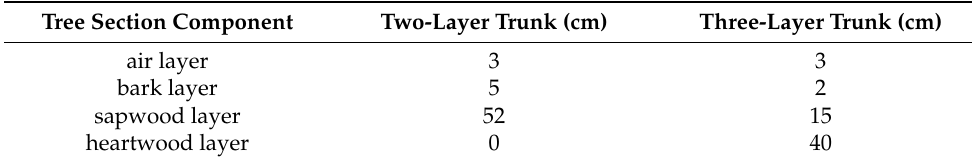
Table 2. The parameter information of the tree layer. Tree Section